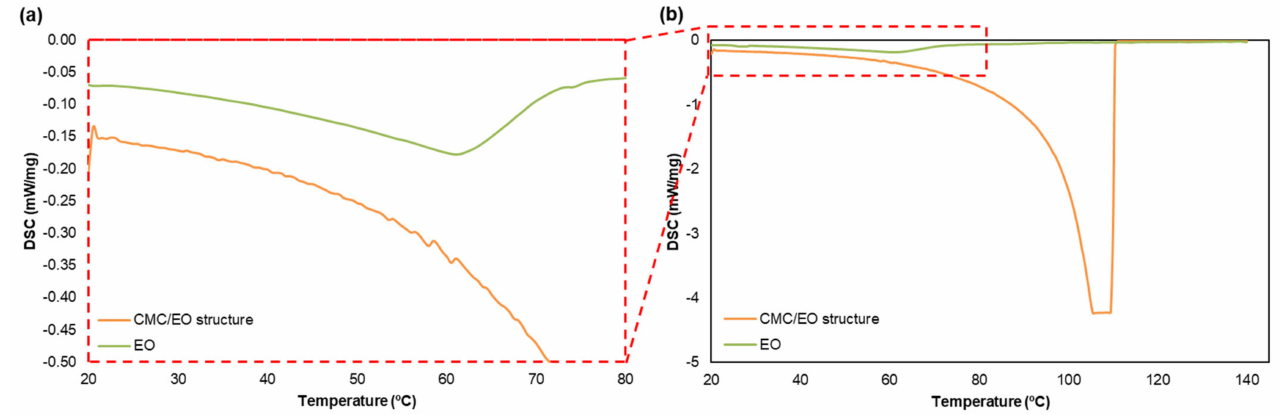
Figure 7. Comparison of DSC of the CMC/EO structure and the eucalyptus essential oil alone, ( a ) between 20 and 80 ◦ C and ( b ) 20 and 140 ◦